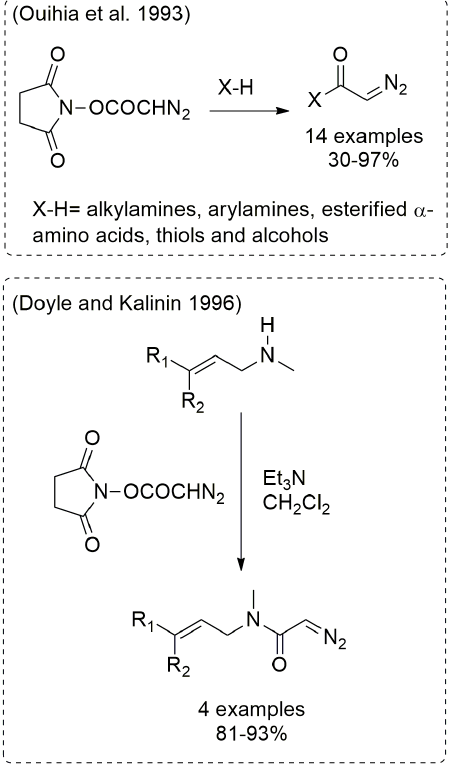
Figure 21 - Diazocarbonyl transfer method.